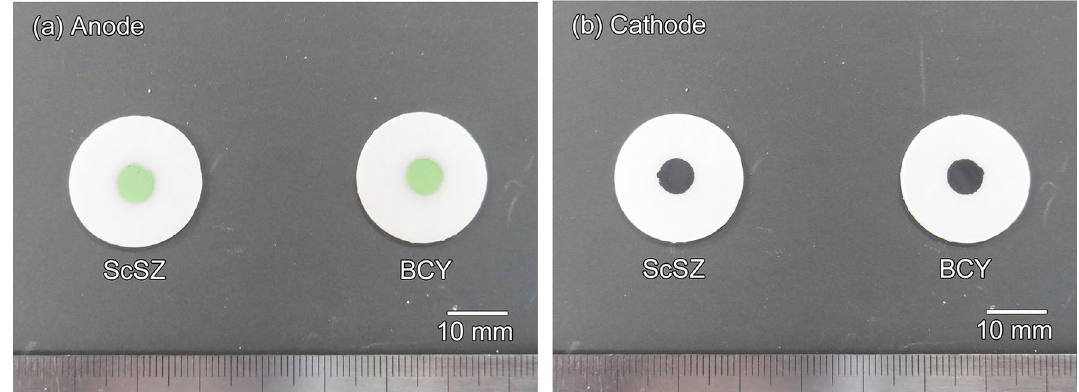
Figure 6. ( a ) Anode and ( b ) cathode sides of SOFCs supported on ScSZ electrolyte and PCFCs supported on BCY